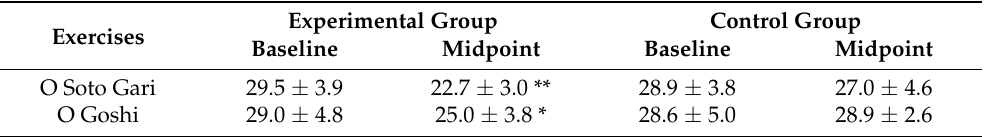
Table 3. The level of judo-specific physical fitness at baseline and midpoint for 10–12-year-old judokas ( n =